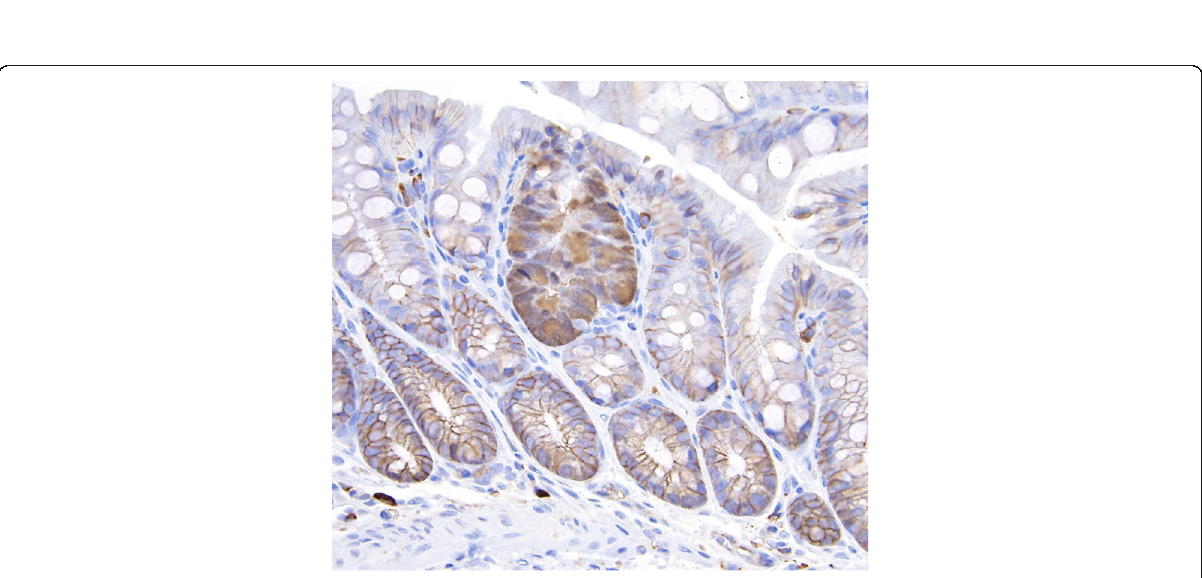
Fig. 3 Adenomas in Apc Min/+ and related models are often covered by a single layer of normal overlying epithelium, unlike in human colorectal adenomas, where the surface mucosa is usually involved by adenomatous epithelium